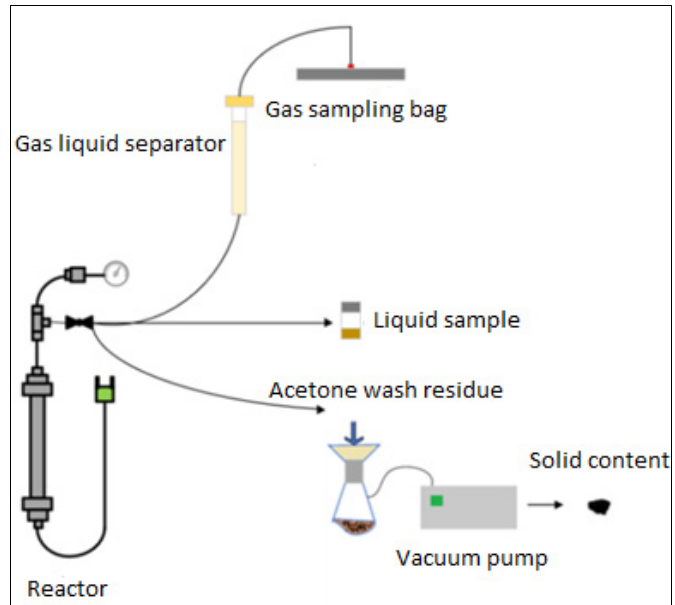
Figure 2. Representation of the solid and liquid samples collection.